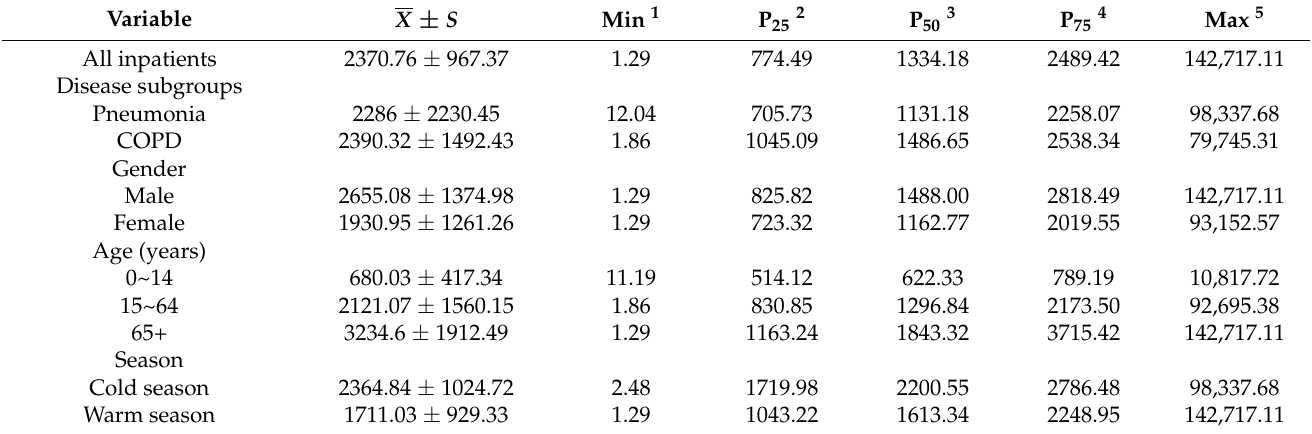
Table 5. Basic information for the period of 2015–2019 on the inpatient expenditure for respiratory diseases (unit: USD). Variable All inpatients Disease subgroups Pneumonia Gender